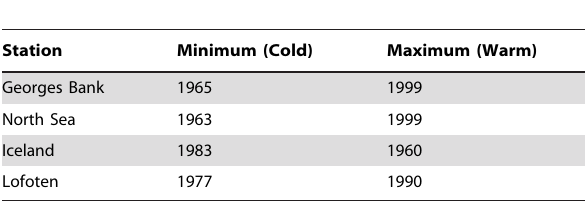
Table 1. Cold and warm years used in the simulations to estimate growth, survival, and fitness at the 4 spawning locations in the North